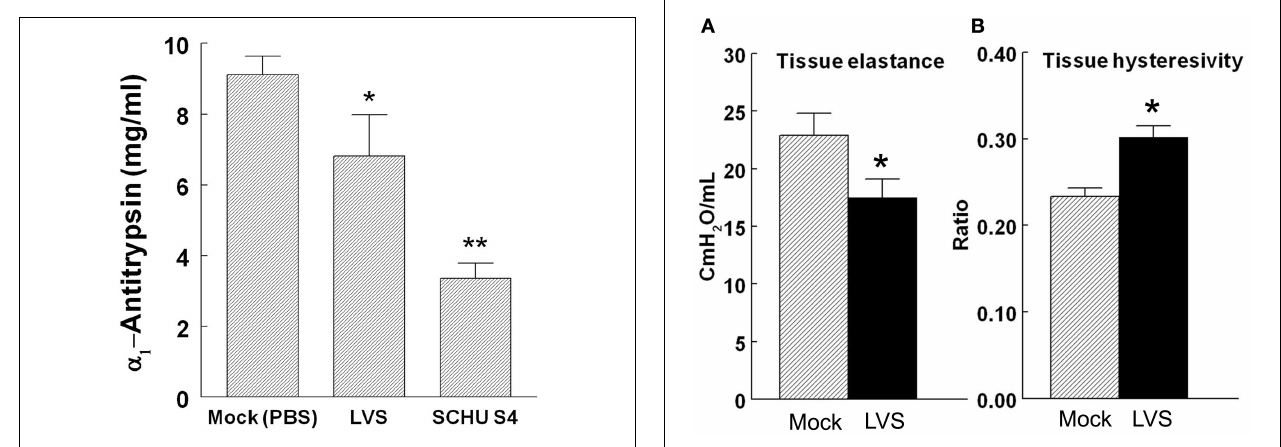
FIGURE 2 | Decreased plasma α 1-antitrypsin following pulmonary F. tularensis challenge. Mouse plasma α 1 -antitrypsin content was determined using 3-day post challenge plasma from each animal ( n = 5/group) as described under Section “Materials and Methods” * = p < 0.05; ** = p < 0.005.